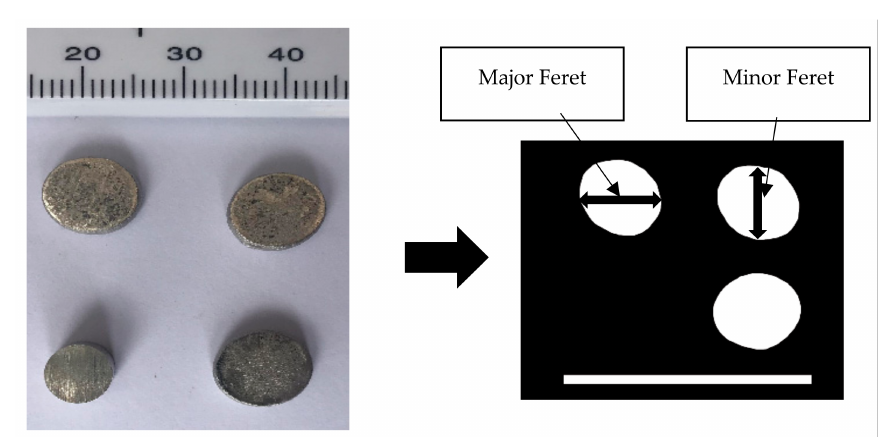
Figure 4. Major and minor Feret measurement illustration.